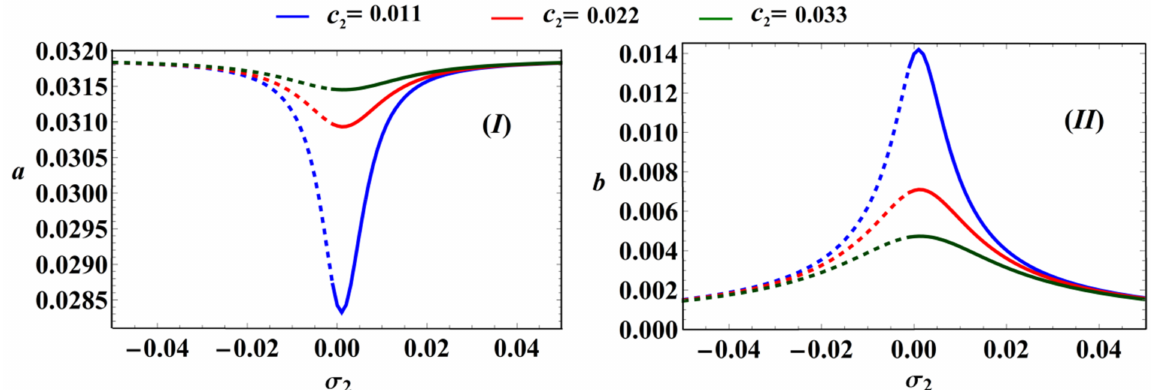
Figure 13. The frequency response at σ 2 = 0, W = 0.448, and c 1 = 0.001 of: ( I ) a ( σ 1 ) , ( II ) b ( σ 1 ) when c 2 = 0.011, ( III ) at c 2 = 0.022, and ( IV ) at c 2 = 0.033.